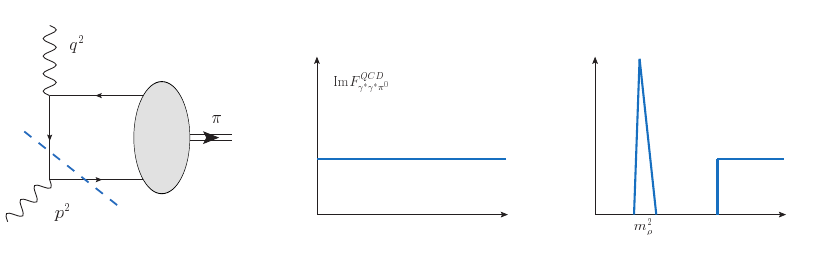
Figure 7. A schematic representation of the LCSR technique: Consider a dispersion relation for the form factor with two nonzero photon virtualities (left) and modify the perturbative spectral density (middle) by the resonance + continuum model with the parameters fixed by